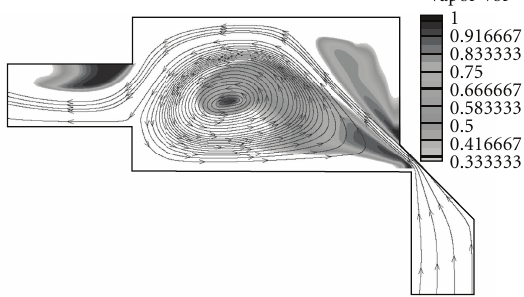
Figure 11: Radial distribution for the liquid-vapor mixture density inside the main vortex